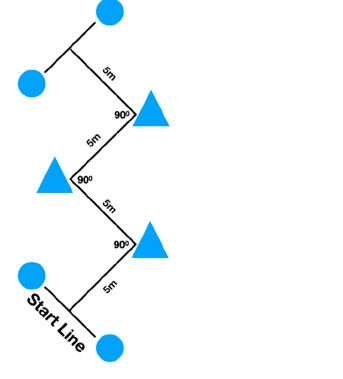
Figure 1. Schematic presentation of the 90° change of direction test. Circles represent the positions of the photocells.